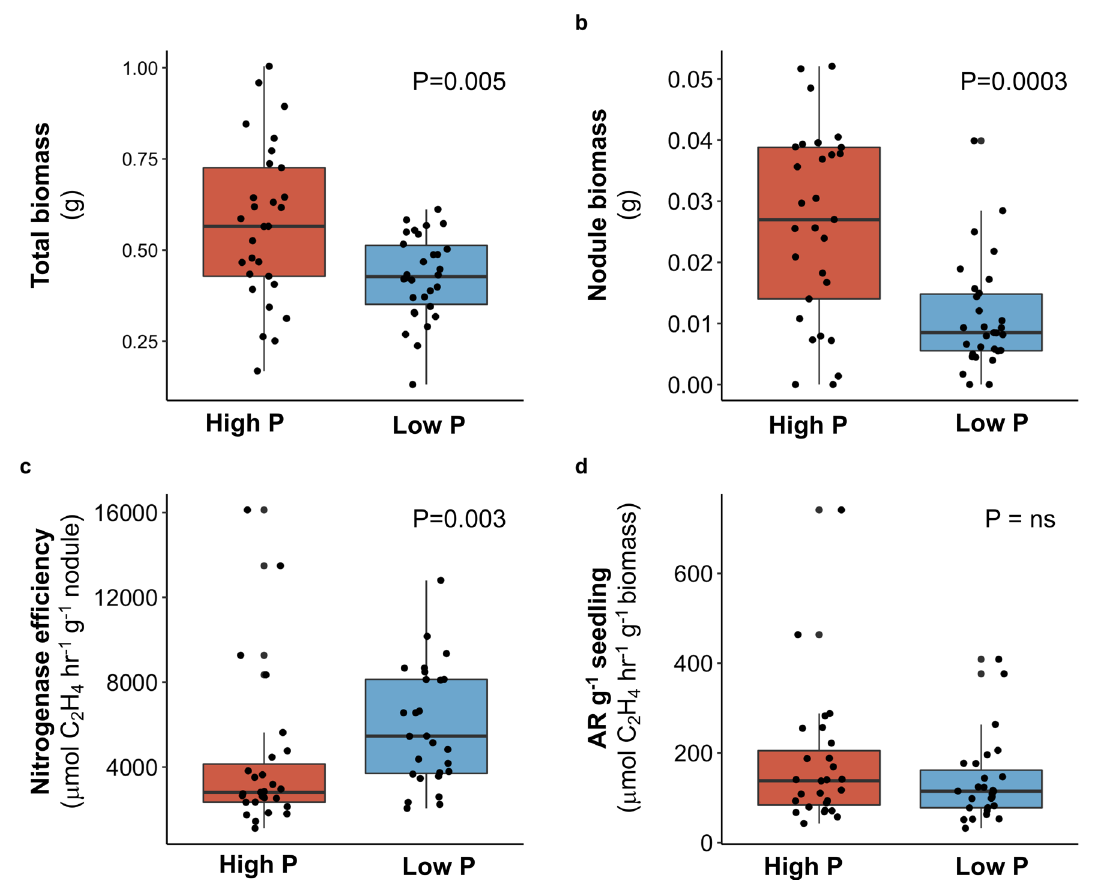
quartile range, the line is the median, and the whiskers are the low- Fig. 2 Whole plant comparisons of high and low P treatment for est or highest value within 1.5 times the interquartile range. Points a total biomass expressed in grams, b nodule biomass expressed represent the values from individual seedlings within each treat- in grams, c nitrogenase efficiency expressed in μmol C H h −1 g −1 2 4 ment. Points were jittered within treatment to prevent nodule, and d acetylene reduced (AR) per gram of seedling expressed in μmol C H h −1 g −1 biomass. Boxes represent the inter- 2 4